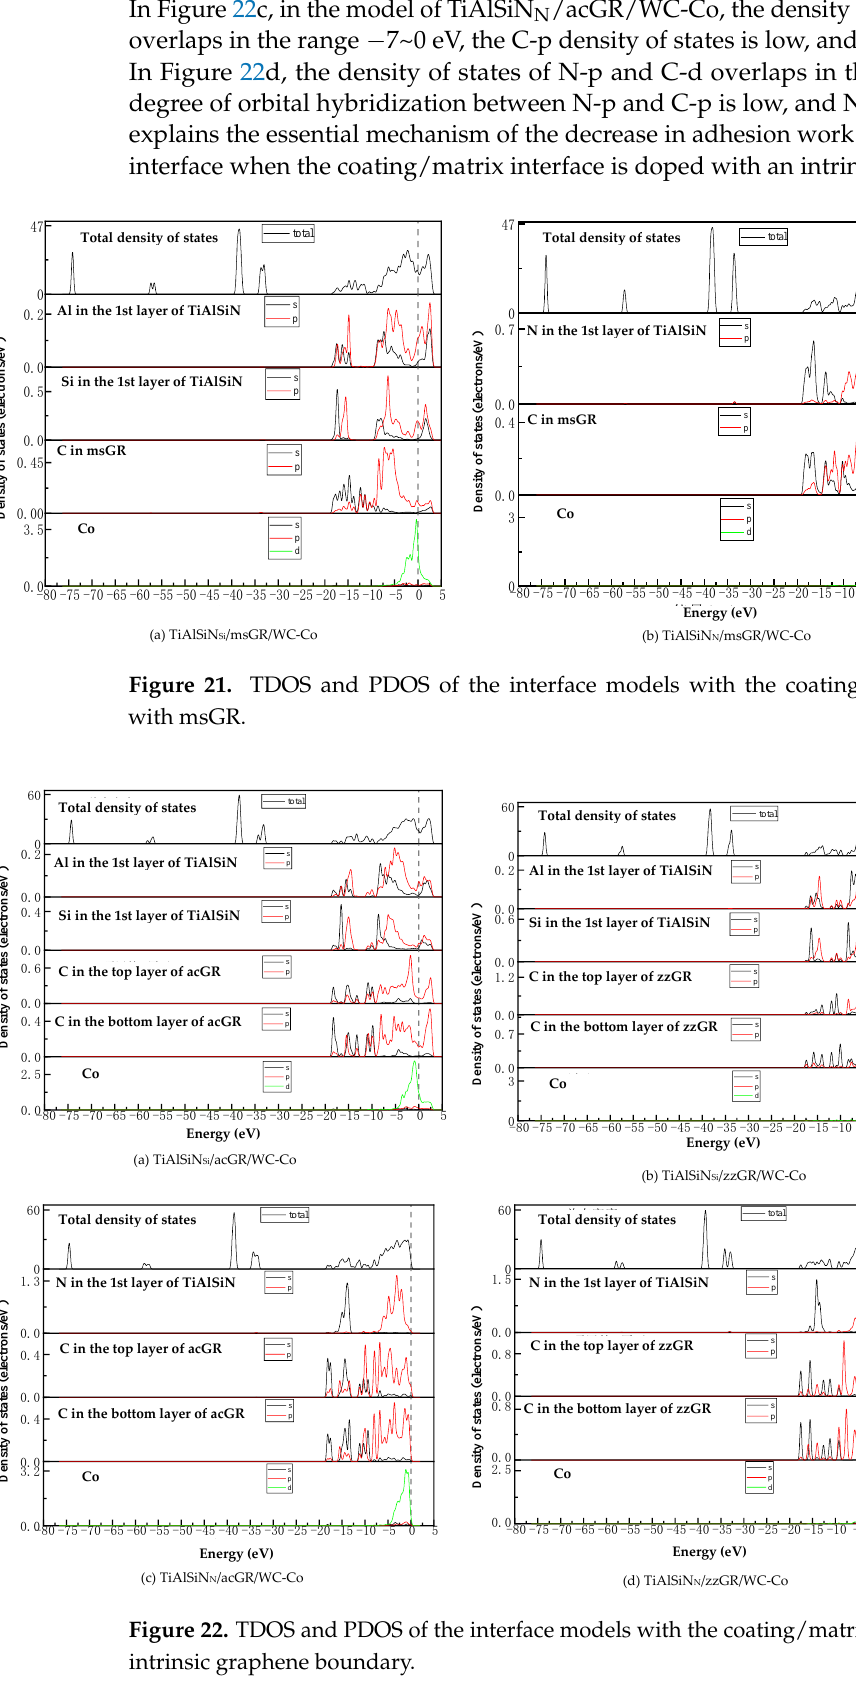
Figure 23. TDOS and PDOS of the interface models with the coating/matrix interface doped with defective graphene. (b) TiAlSiN Si /tdGR/WC-Co